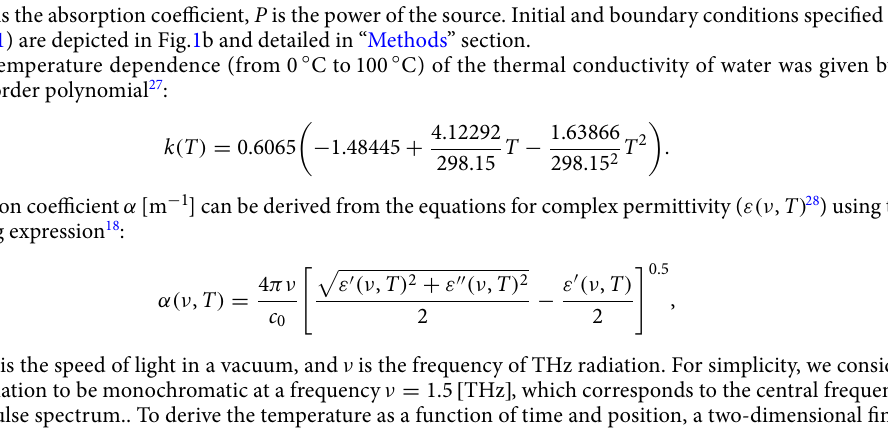
µ J 15 515 fs , t h ) and ( d ) when the next THz pulse comes ( t c = [ ] = [ ]